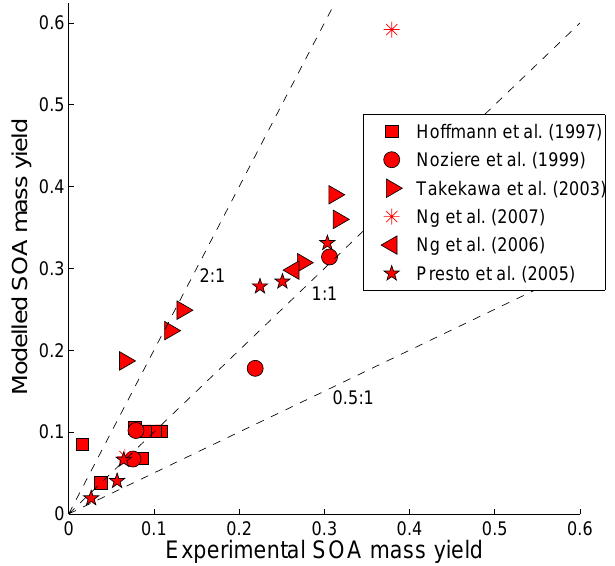
Fig. 1. Measured versus modelled aerosol mass yields for the α - pinene photooxidation smog chamber experiments reported in Ta- ble